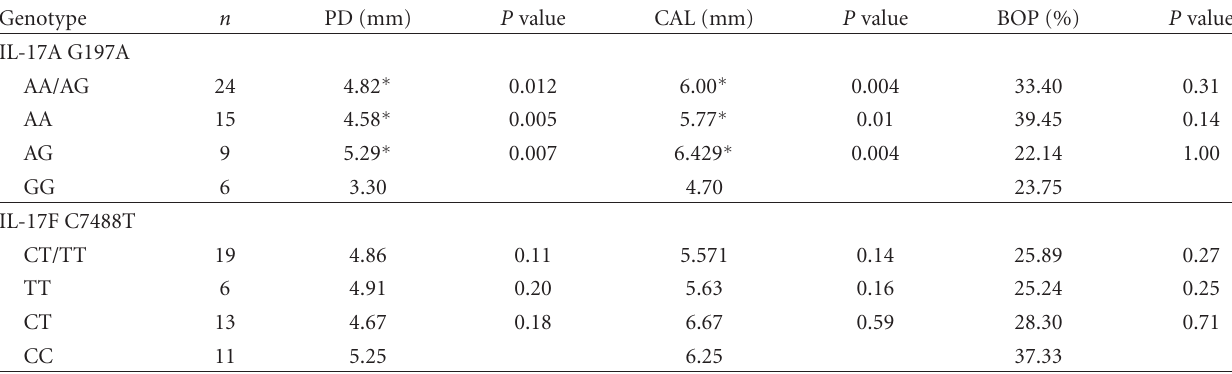
Table 4: Association between IL-17A G197A and IL-17F C7488T polymorphisms and clinicopathological features of chronic periodontitis.